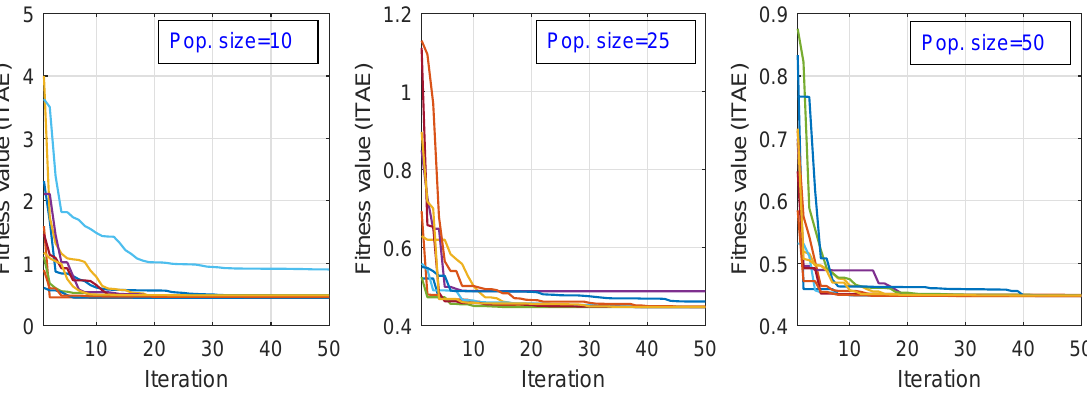
Figure 7. Fitness values obtained with different population size for 10 different trial. Popu- lation size is 10, 25, and 50 in (a), (b), and (c), respectively.